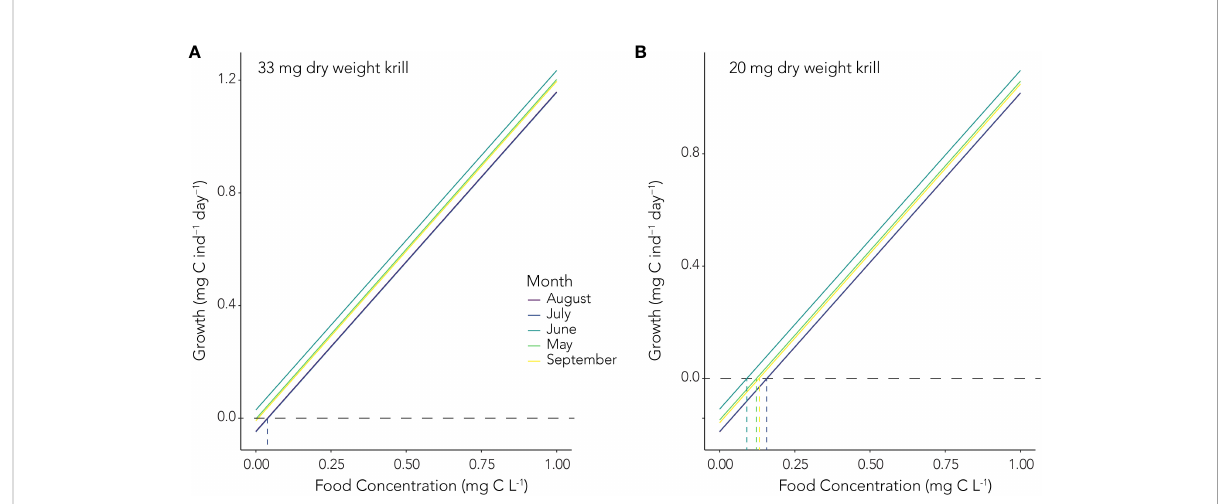
FIGURE 6 Growth potential (Gp, mg C ind. -1 day -1 ) of (A) a 33 mg DW juvenile krill and (B) a 20 mg DW juvenile krill at a range of food concentrations (mg C L -1 ) from May to September. The horizontal dashed lines indicate zero growth, values above this represent growth, while values below represent shrinkage. The vertical dashed lines denote mark the point of zero growth and the corresponding food concentration in each month, colored